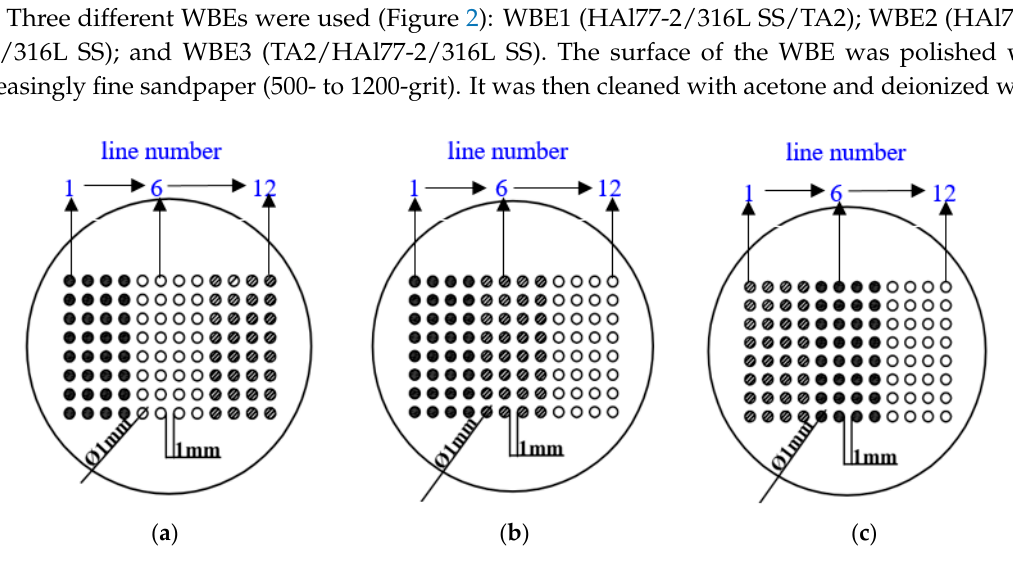
Figure 2. Schematic of the three WBEs with different metal arrangement sequences: ( a )